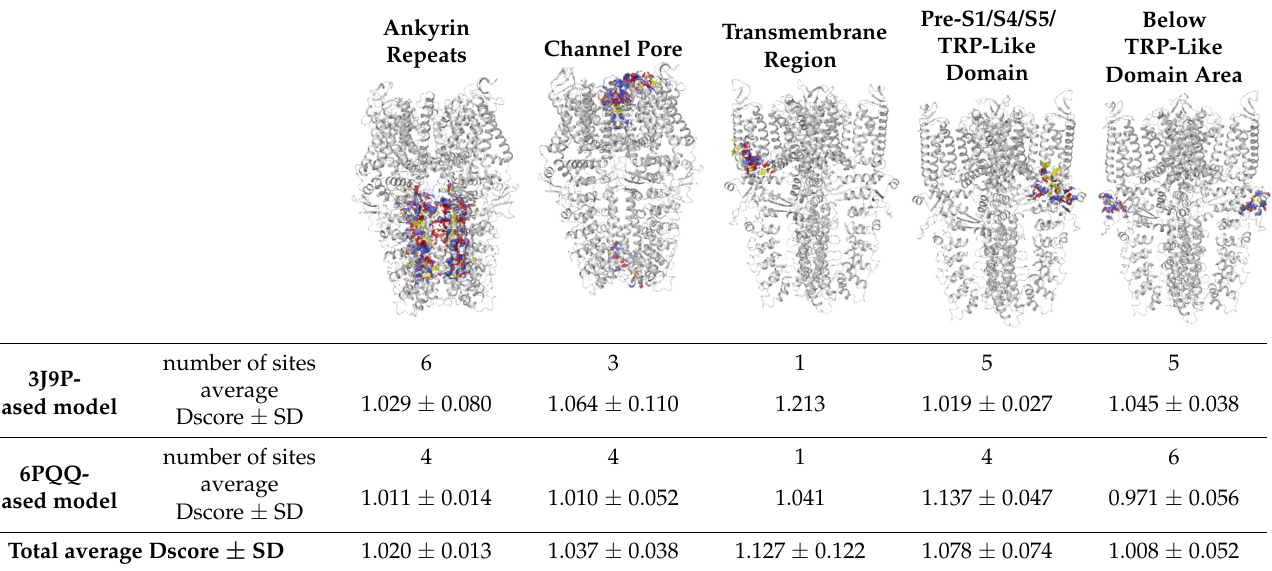
Figure 4. Structure of TRPA1 antagonists: A-967079 and HC-030031 (with a numbering scheme of 1,3-dimethylxanthine core).